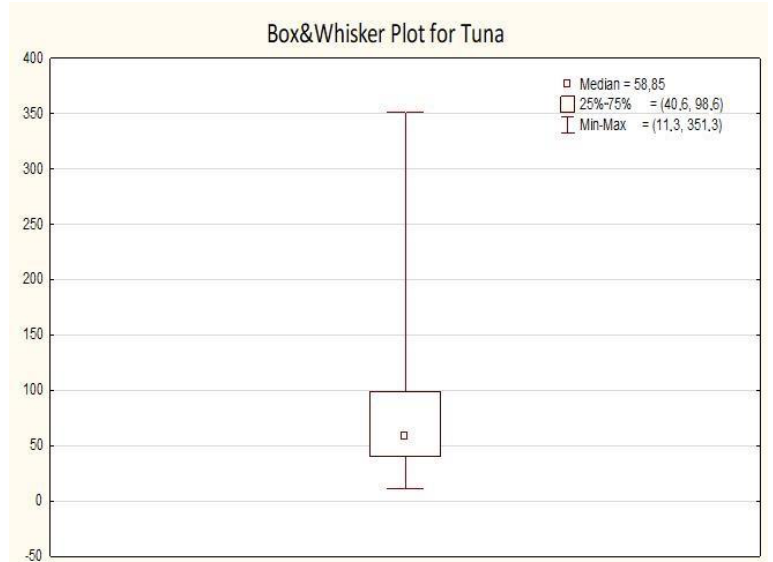
Figure 2. Box and whisker plot for content of Hg for canned tuna produced in different countries, including Poland ( n = 57) (µg/kg).